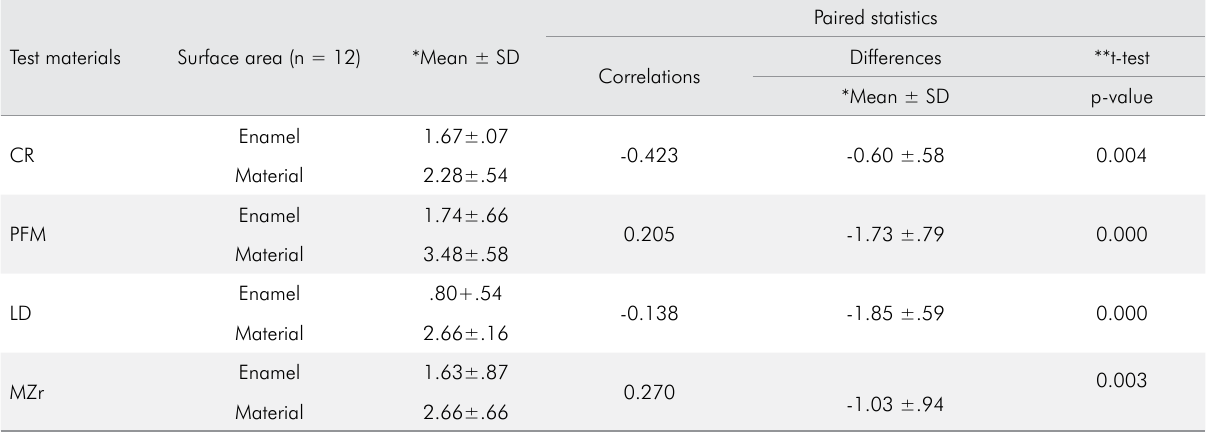
Table 4. Results of paired samples statistics for comparison of material and enamel surface area for each test materials.